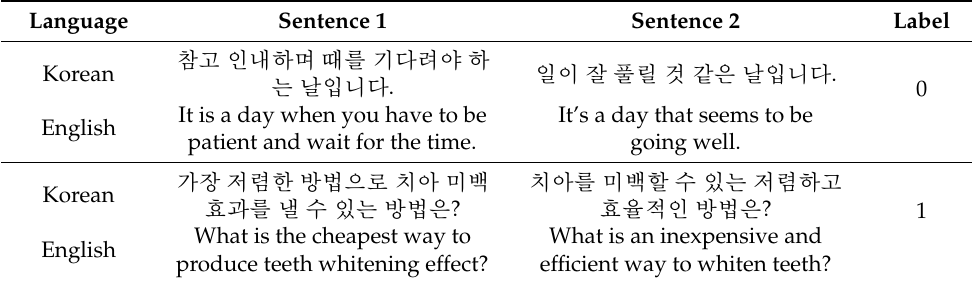
Table 2. Example of Korean sentence pairs and labels.